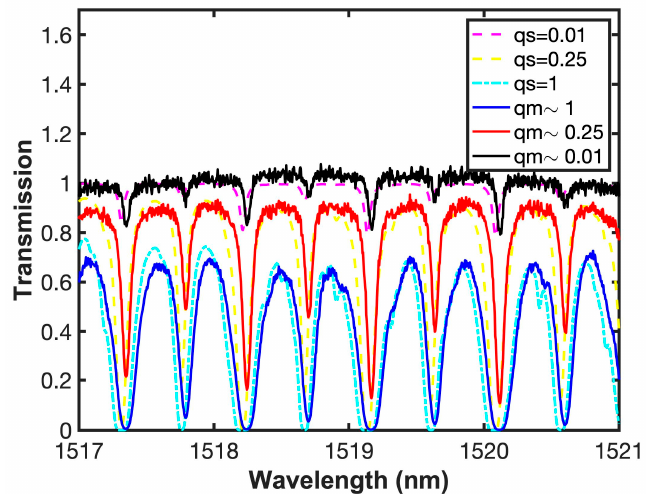
Figure 10. Measured (qm) and simulated (qs) gas transmission at different concentrations.